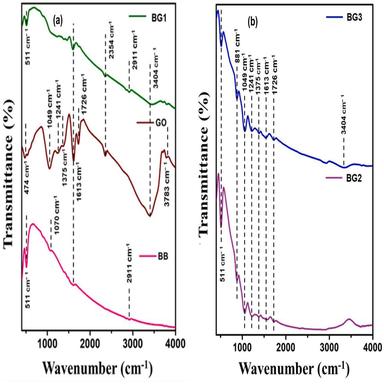
FTIR spectra of (a) BB, GO and BG1 and (b) BG2, BG3 nanomaterials.